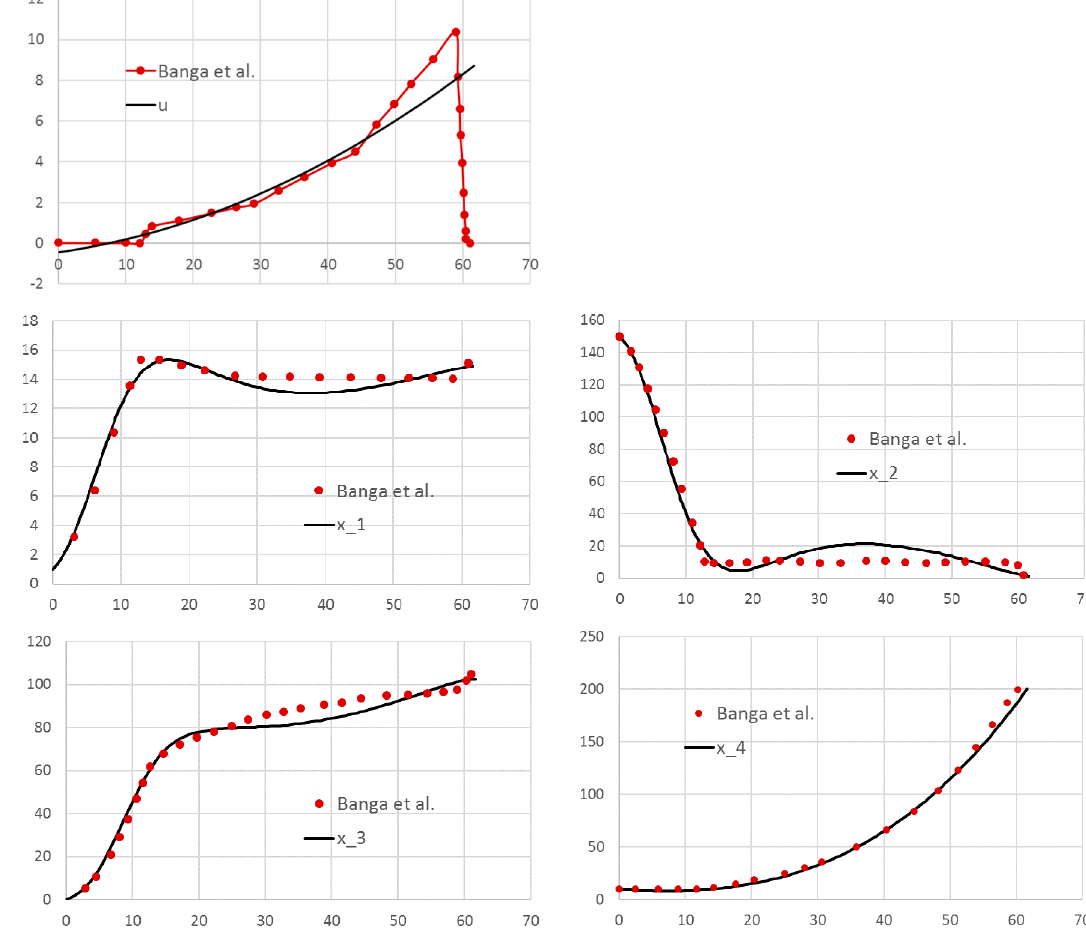
Figure 25. Direct comparison of spreadsheet solution with reported solution obtained by Banga et al. for problem 3.4.